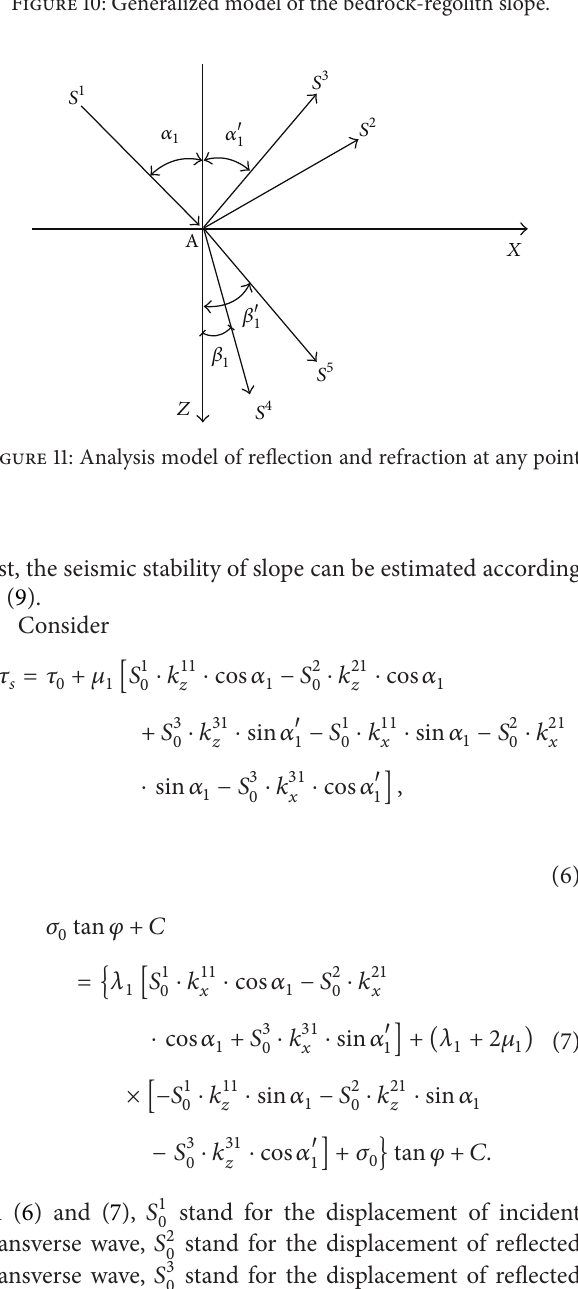
Figure 10: Generalized model of the bedrock-regolith slope.